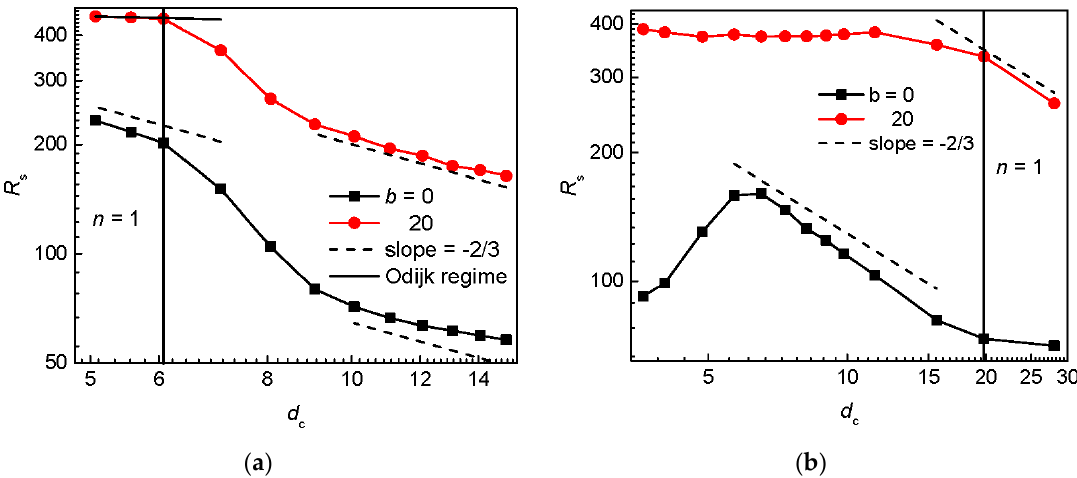
Figure 6. Extension along the posts for a flexible and semiflexible circular chain in an array of posts of varying diameter d p separated by S p = 12 ( a ) and with passage width w p = 2 ( b ) as a function of the size of the interstitial space in a logarithmic scale. The solid vertical line demarcates the region with the dominance of single-occupancy for a semiflexible chain.